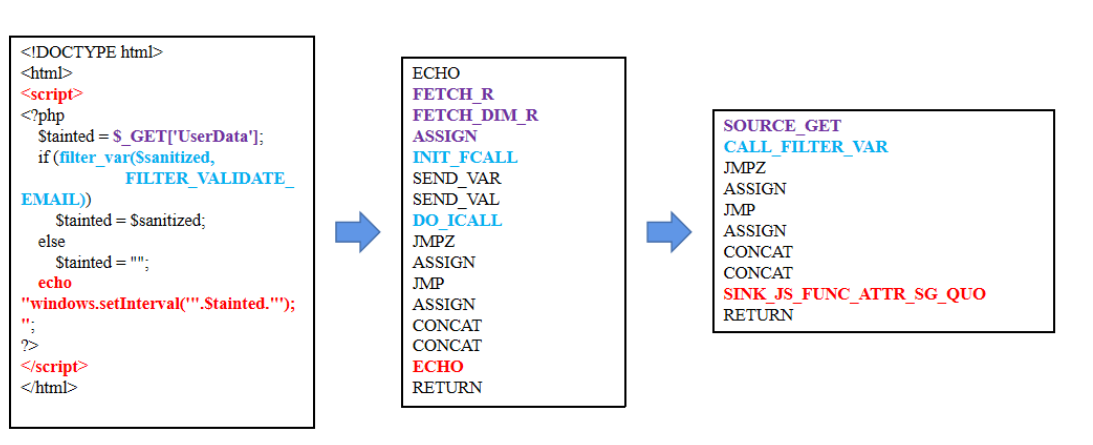
Figure 2. Source versus opcode